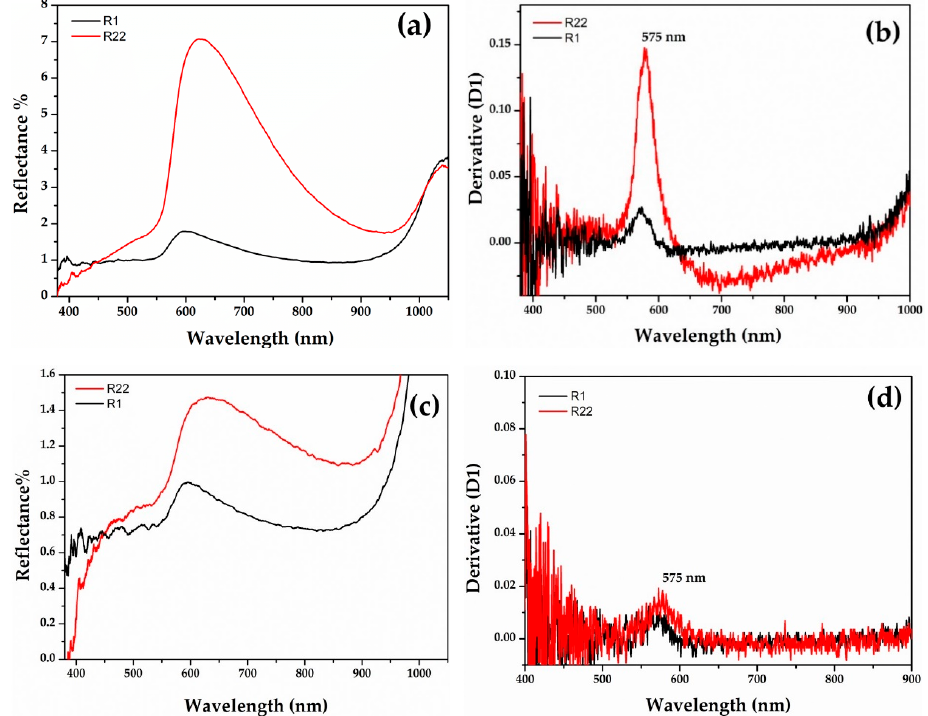
Figure 7 . Reflectance spectra of Gr-3 groups with red ( a ) and dark transparent ( c ) layer. The first derivative of the red ( b ) and dark transparent layers ( d ). derivative of the red ( b ) and dark transparent layers ( d